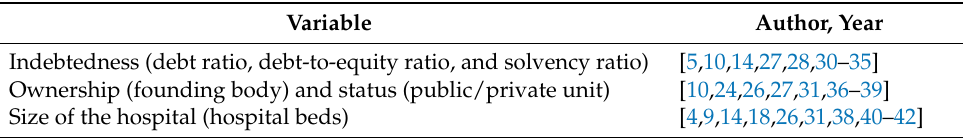
Table 2. List of variables used in the financial and economic analysis of healthcare. Variable Author, Year Indebtedness (debt ratio, debt-to-equity ratio, and solvency